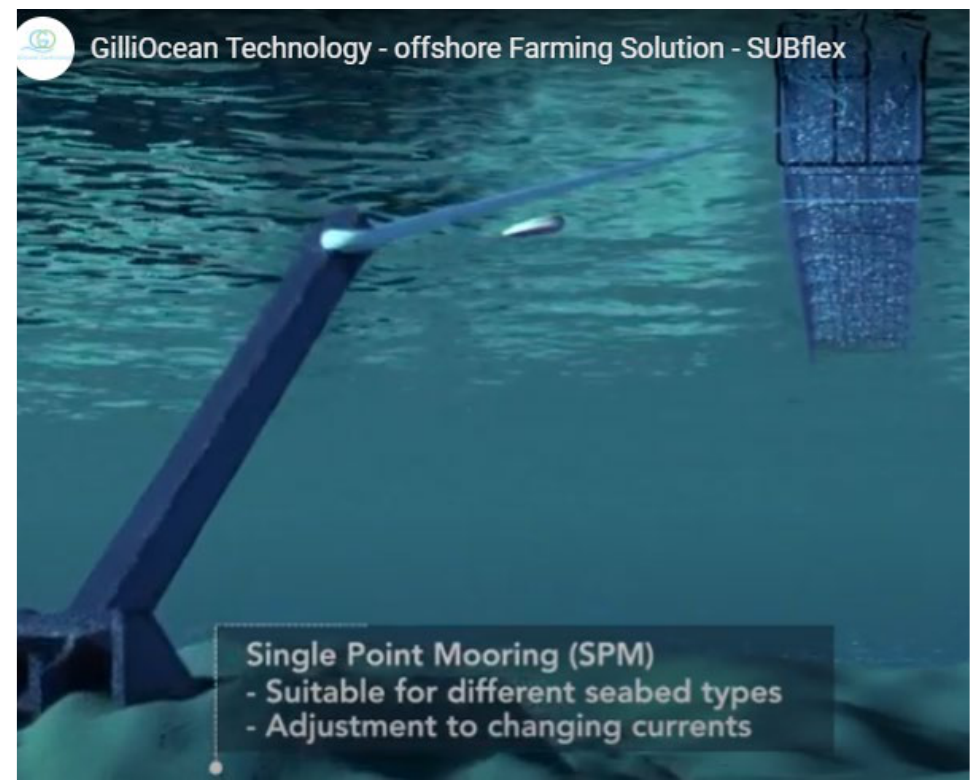
Figure 12. Linear tensile system—single point mooring— Gili SUBFlex — (https://www.giliocean.com/selected-projects (accessed on 22 September 2022)).